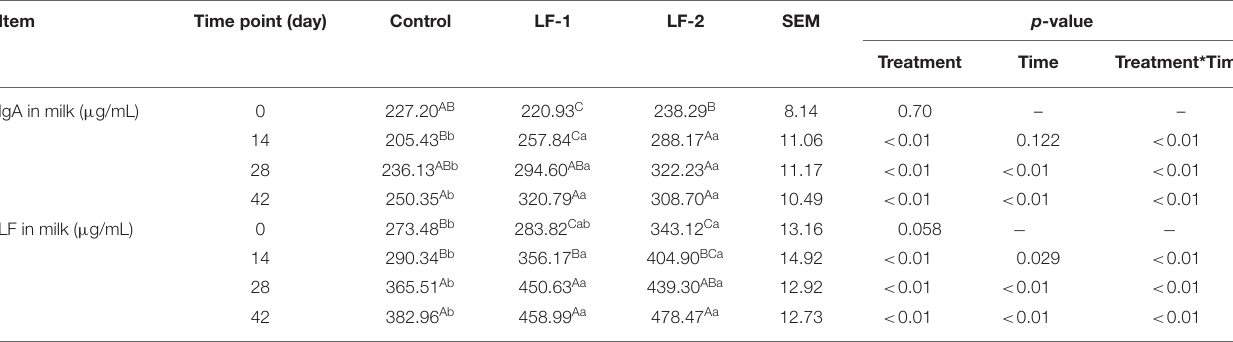
TABLE 6 | Effects of supplementation of BLFc at 100 mg/kg/day (LF-1) or 200 mg/kg/day (LF − 2) on milk IgA and lactoferrin in dairy